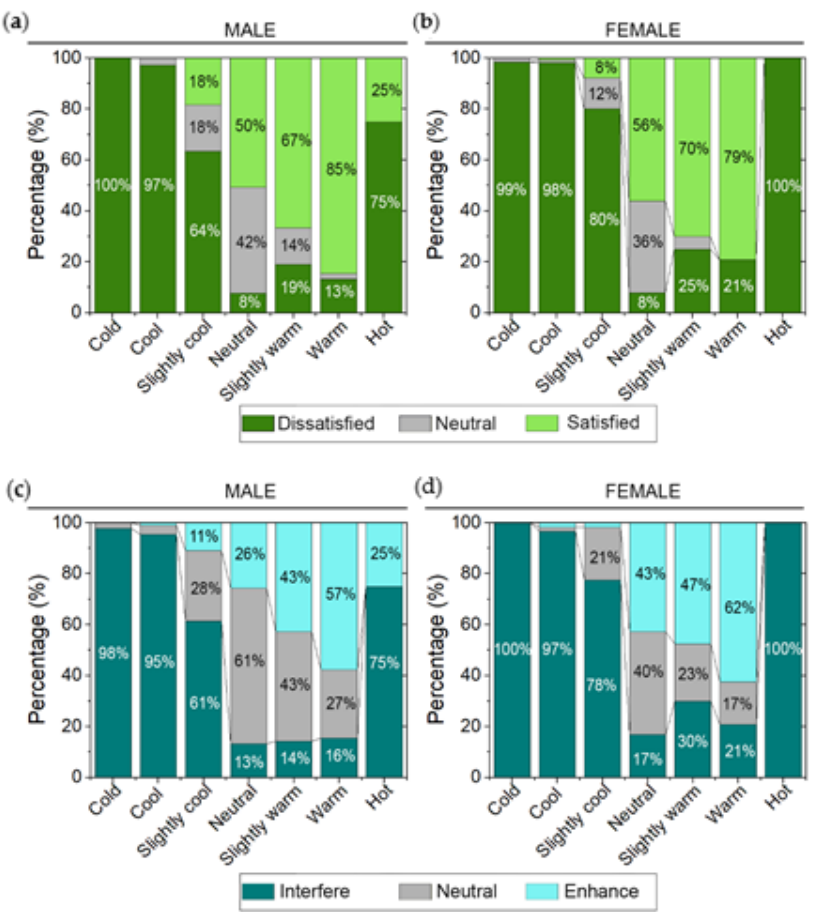
Figure 6. ( a ) Distributions of TSaV versus TSV results for male students; ( b ) Distributions of TSaV versus TSV results for female students; ( c ) Distributions of TIP versus TSV results for male students; ( d ) Distributions of TIP versus TSV results for female students.